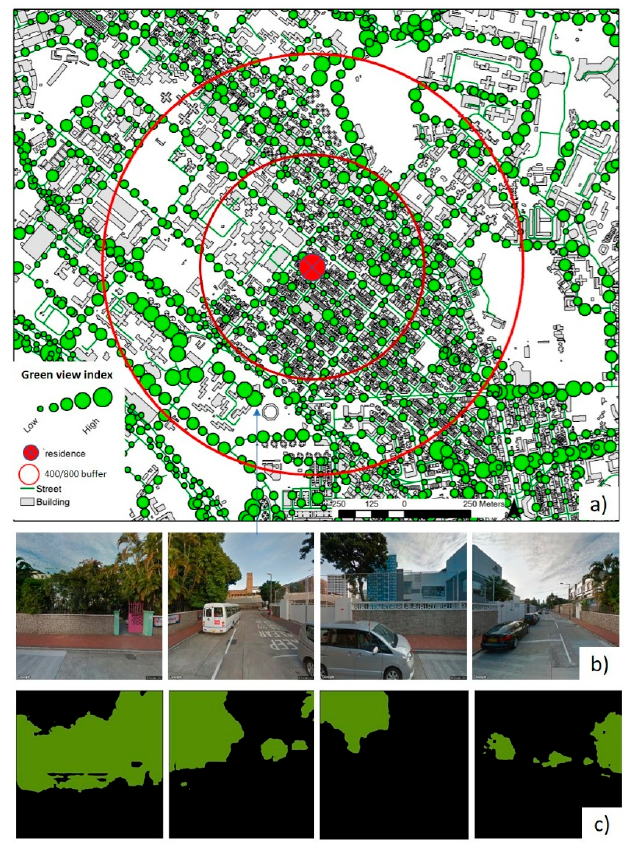
Figure 1. Eye ‐ level street greenness assessment with PSPNet, a computer deep learning technique. ( a ) Green view index of the 400/800 m buffer around a dwelling location. Sampling points with 50 m spacing were generated in the street centerlines. ( b ) With a Python script developed by us, we can retrieve four streetscape images with a 90 ‐ degree field of view for a point. ( c ) All street vegetation in images were segmented with PSPNet.